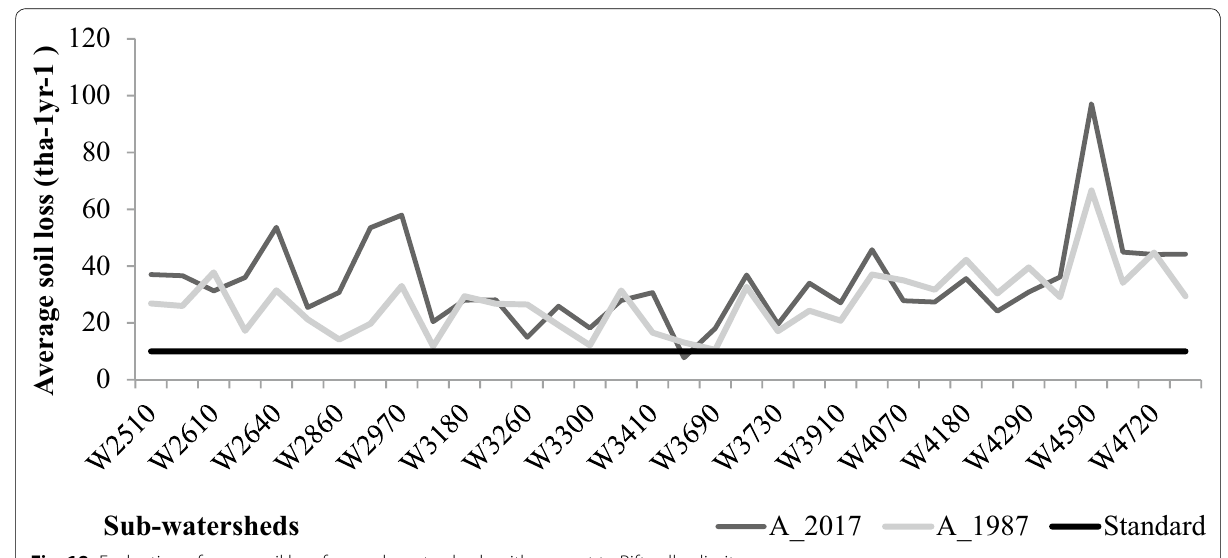
Fig. 18 Evaluation of mean soil loss from sub-watersheds with respect to Rift valley